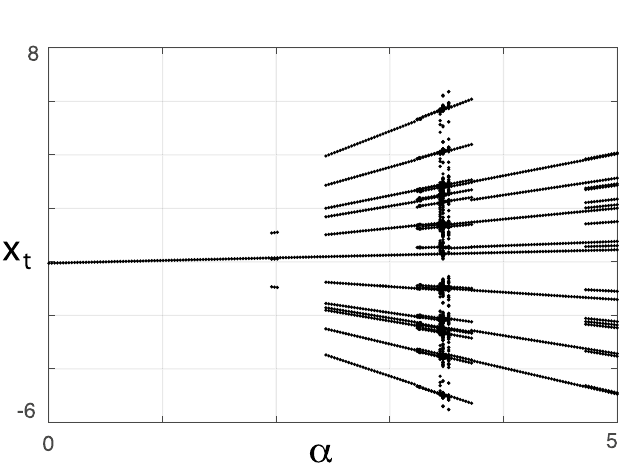
, β 0.9, δ 0, γ 1, η 0.05, µ 0.9 and different → ∞ = = = = − =